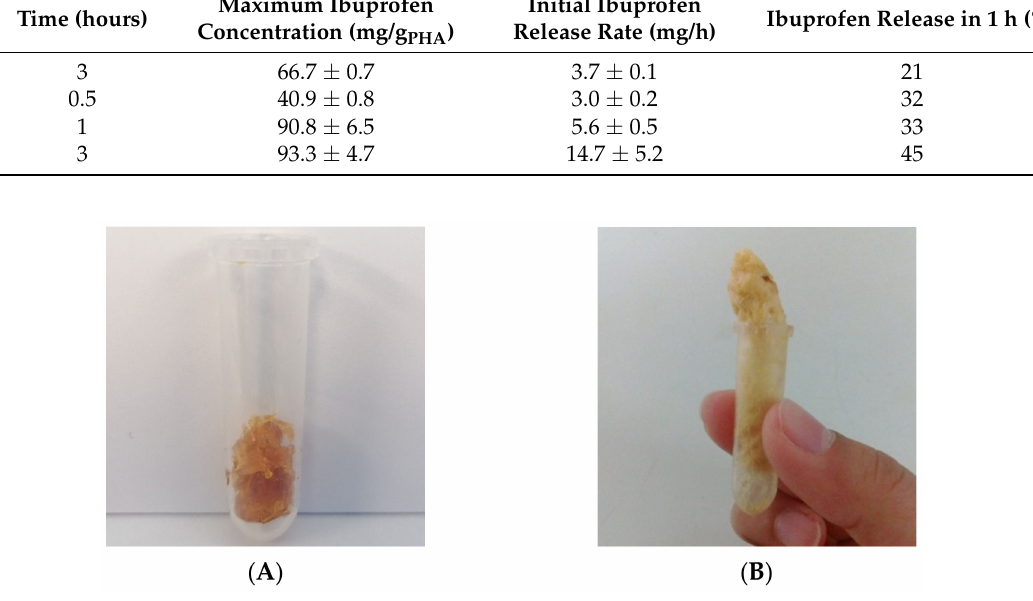
Figure 3. mcl-PHA before ( A ) and after ( B ) impregnation for 3 h at 20